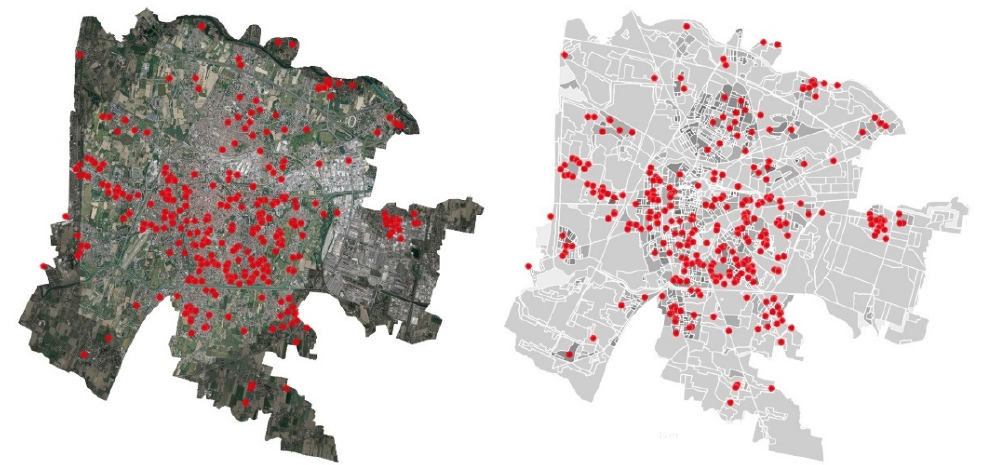
Figure 2. Location of the analyzed properties: on the aerial view of the city of Padua from Google Earth ( left panel) and the urban fabric plus population density ( right panel).